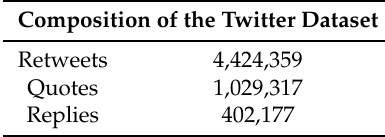
Table 2. Composition of the Twitter dataset. Retweets are the vast